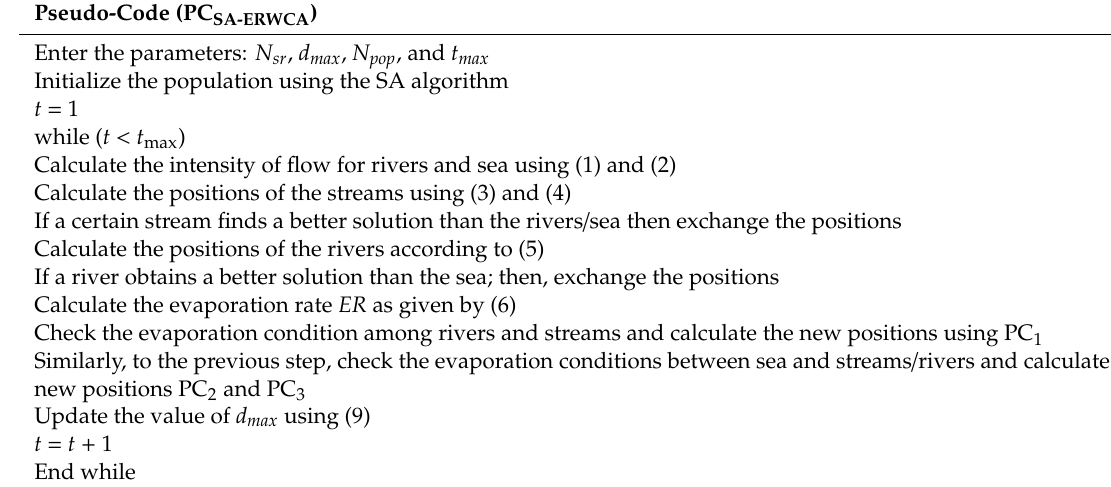
Table 5. The complete pseudo-code of the